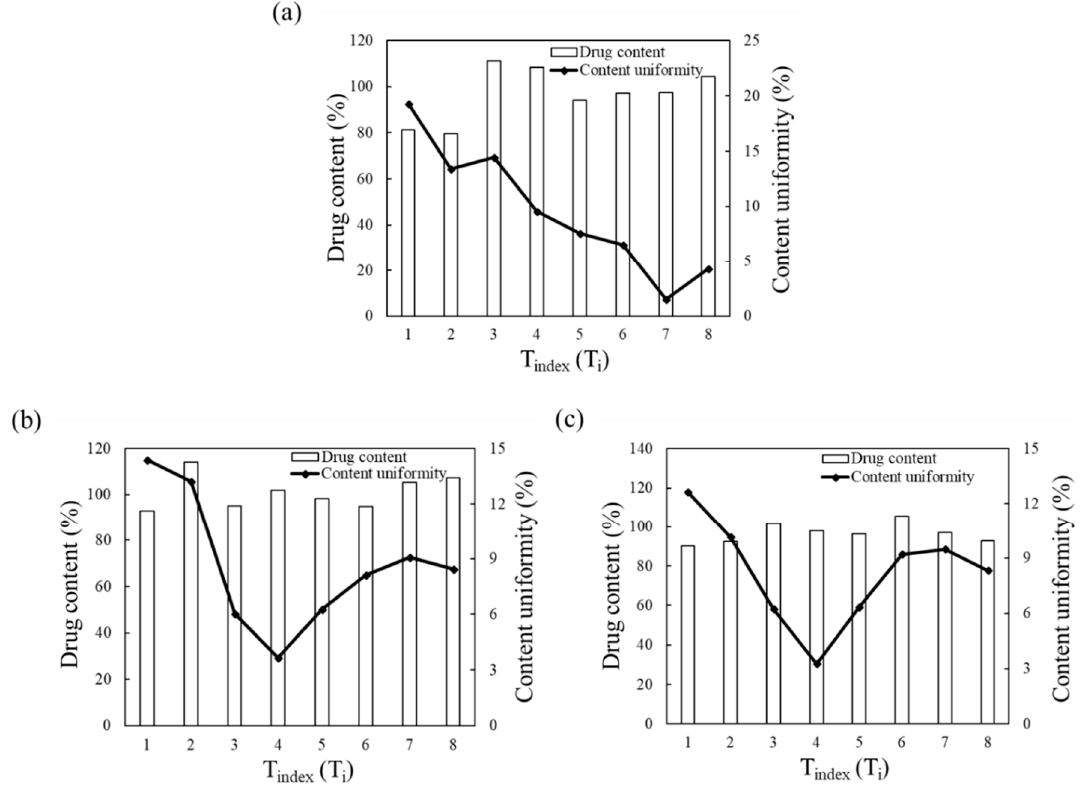
Figure 10. Graphs for each blending simulation result according to T i : ( a ) V-blender at laboratory-scale, ( b ) V-blender at pilot-scale, and ( c ) double-cone blender at pilot-scale. For each graph, the bars corresponding to the left axial and the line corresponding to the right axial represent the drug content (%) and CU (%), respectively.